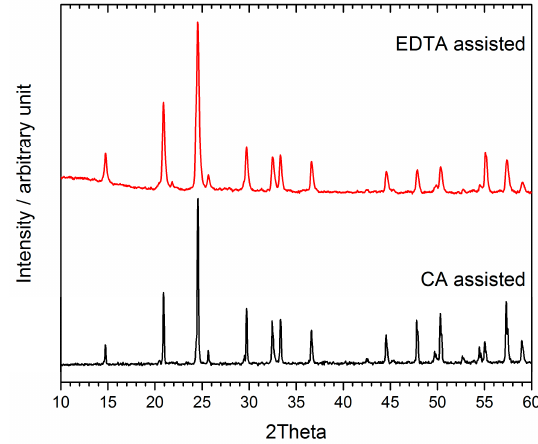
Figure 4. Recorded XRD patterns obtained from the sol–gel prepared samples with two different complexing agents treated at 1100 °C. The diffraction peaks of the EDTA-assisted sample are considerably broader with respect to the CA-assisted product